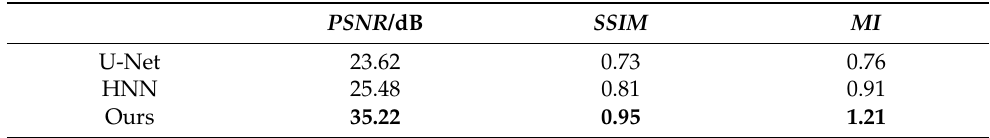
Table 1. Test results for complex object datasets and comparison of related methods ( PSNR , SSIM , and MI